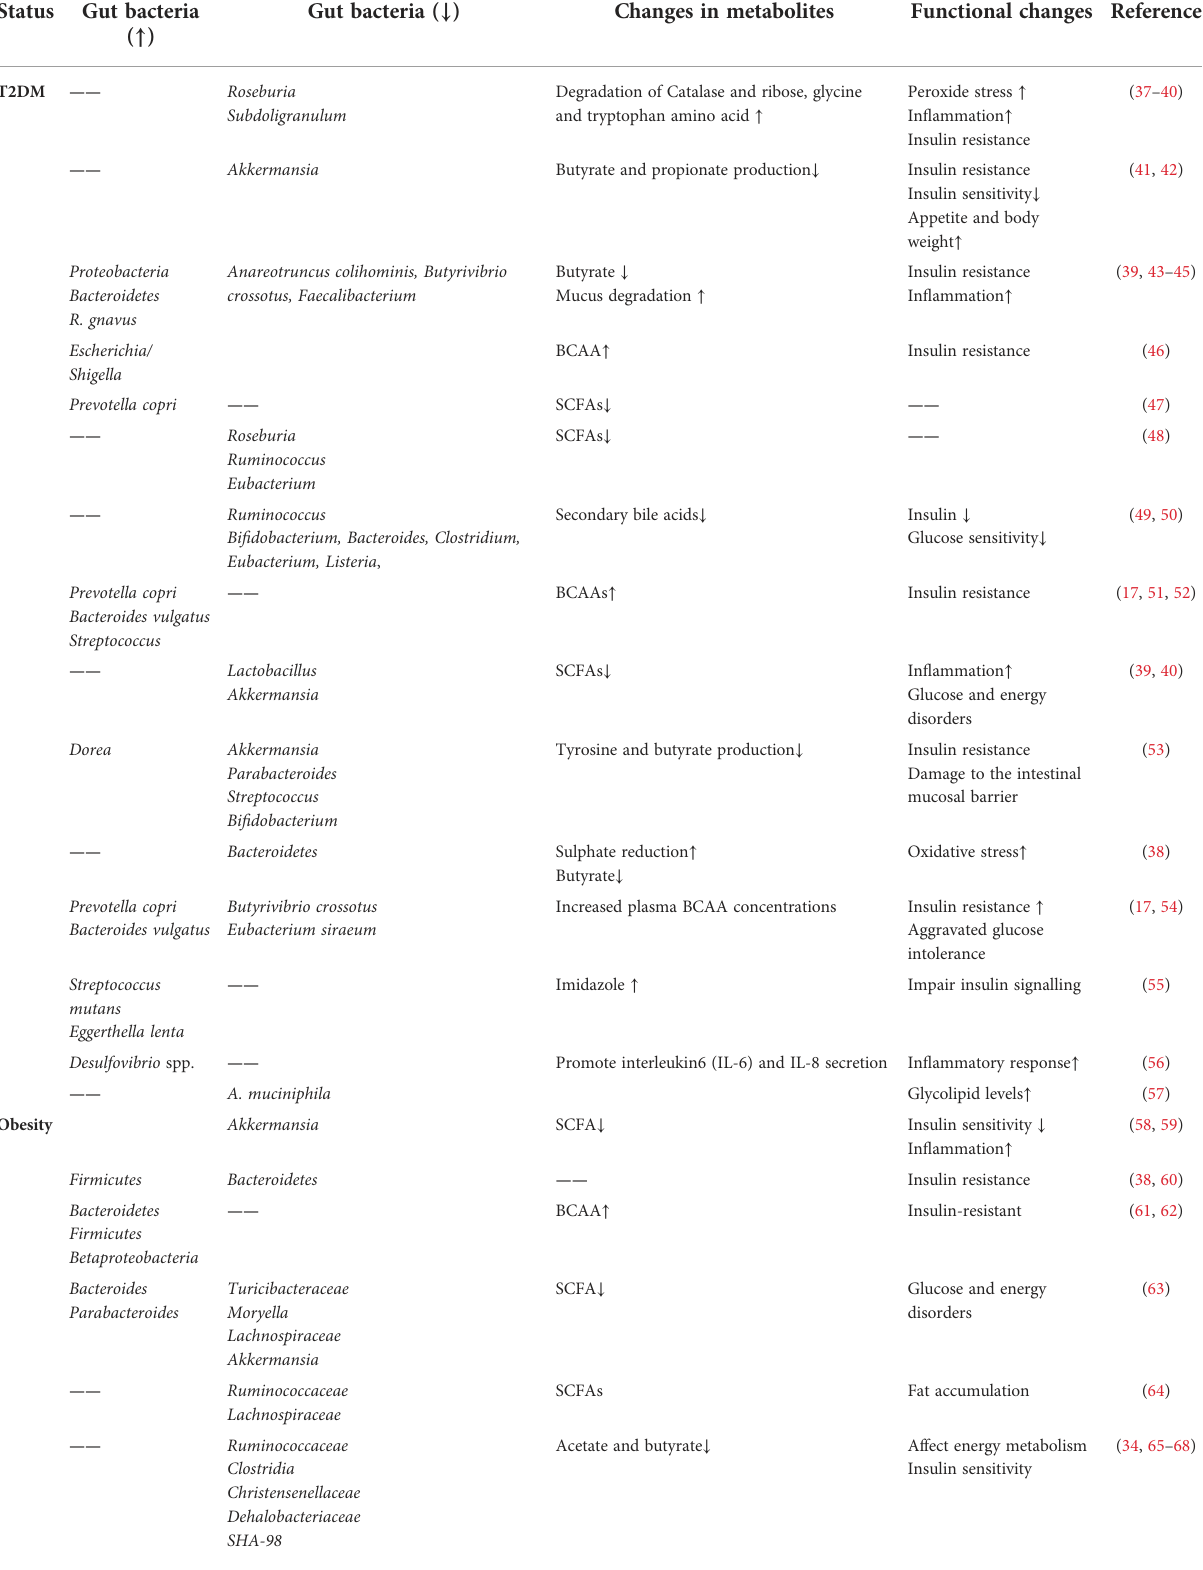
TABLE 1 Changes in intestinal fl ora and metabolites in T2DM and obesity.